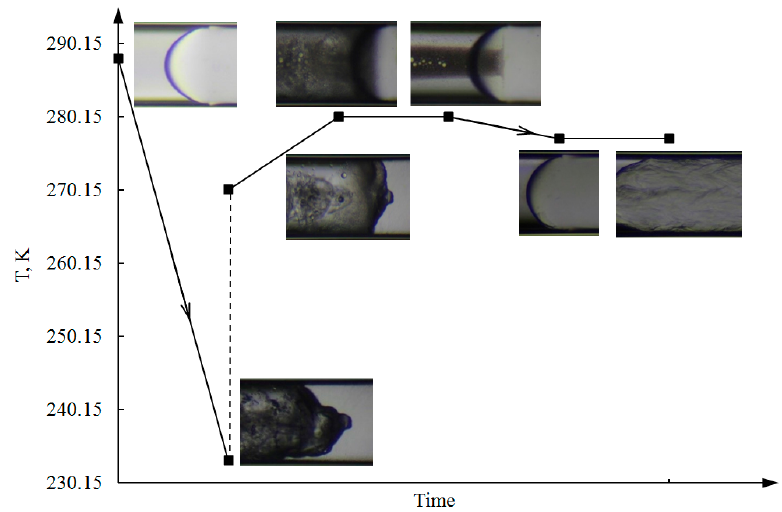
Figure 6. Morphology of CP hydrate with the temperature profile at different times.